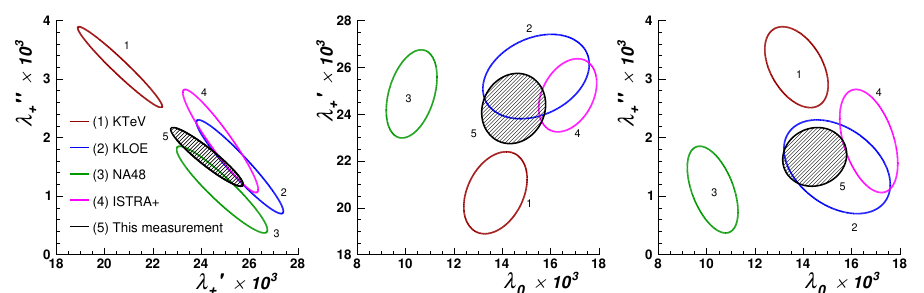
Figure 8. One sigma (39.4% CL) contours for the parameters of the Taylor expansion obtained from the joint analysis together with the combinations of K e 3 and K µ 3 measurements by the KTeV [15], KLOE [16, 17], NA48 [18, 19], and ISTRA + [20, 21] Collaborations provided by